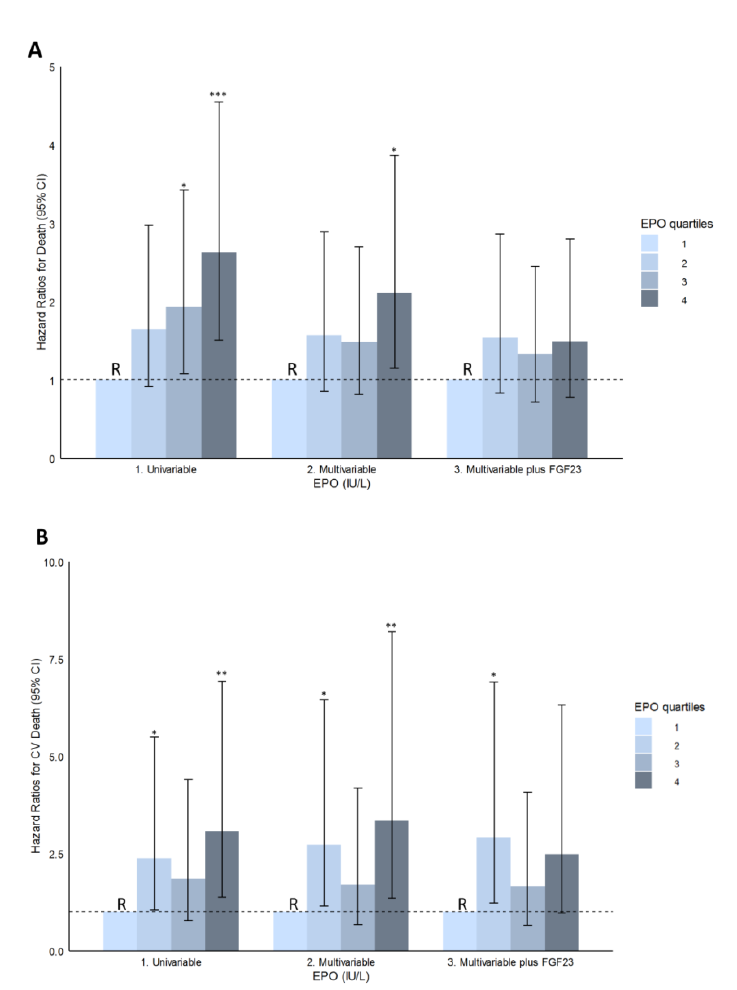
Figure 2. Hazard ratios and corresponding 95% confidence intervals are depicted for risk of death, both all-cause ( A ) and cardiovascular death ( B ), according to quartiles of erythropoietin levels. First, the univariate association is shown. Second, the multivariable adjustment is performed with adjustment for age, sex, body surface area (BSA), eGFR, proteinuria, time since transplantation, presence of diabetes, systolic blood pressure (SBP), total cholesterol, and use of calcineurin inhibitors, proliferation inhibitors, and angiotensin-converting enzyme (ACE)-inhibitors and angiotensin II-receptor blockers (ARBs). Third, adjustment for FGF23 is performed following the multivariable adjustment. The first quartile was chosen as a reference group in all analyses. Significance levels are indicated by numbers of asterisks, i.e., *** < 0.001, ** < 0.01, * < 0.05; Abbreviations—BSA, body surface area; CI, confidence interval; eGFR, estimated glomerular filtration rate.